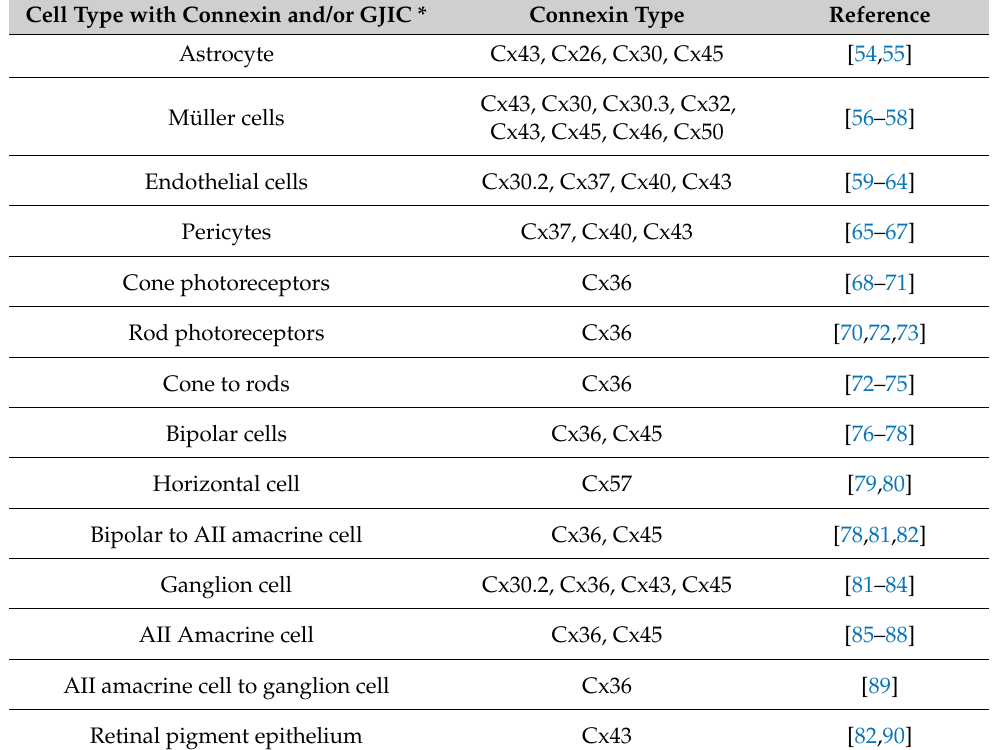
Table 1. Connexin type expression in retinal